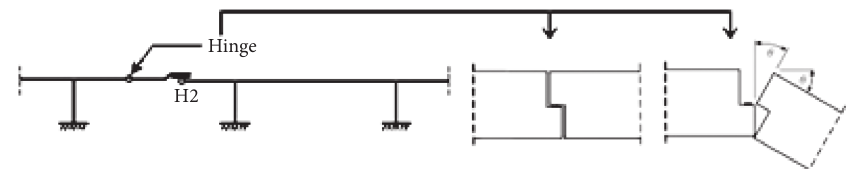
Figure 16: View of in-span hinges in bridge